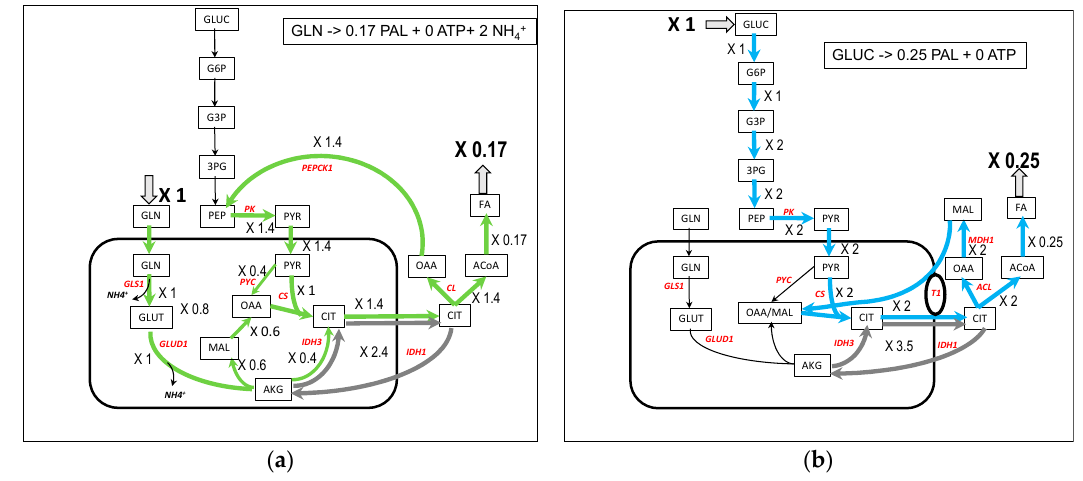
Figure 6. A simplified representation of palmitate synthesis from glutamine ( a ) and glucose ( b ). In gray, cycling of citrate accompanying the conversion of NADHm in NADPHc needed for palmitate synthesis. The complete model is in Figure S6a and S6b in the Supplementary Materials.